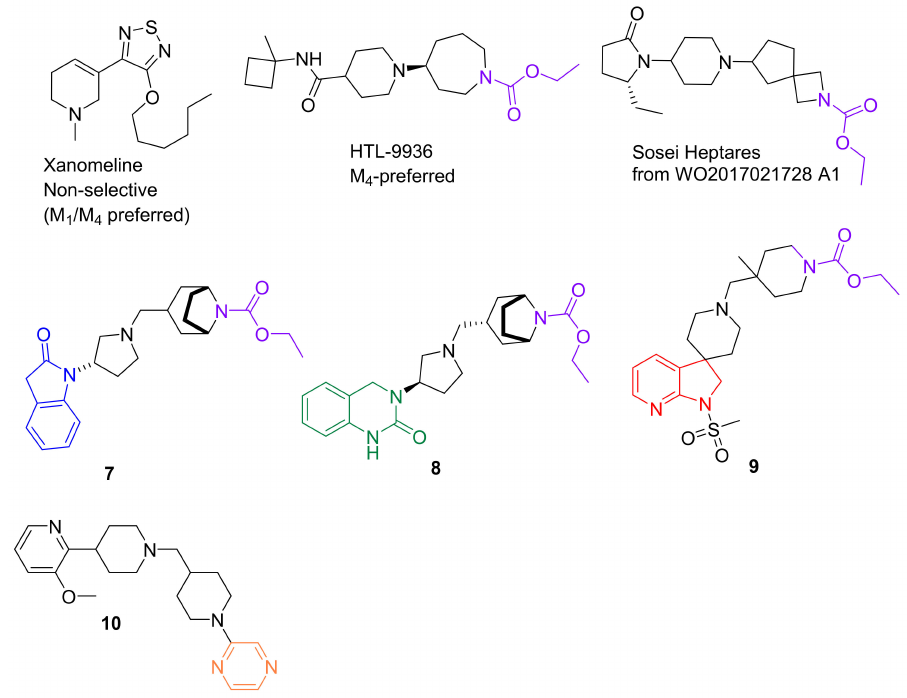
Figure 5. Recent examples of highly selective dual M1/M4 (or M4)